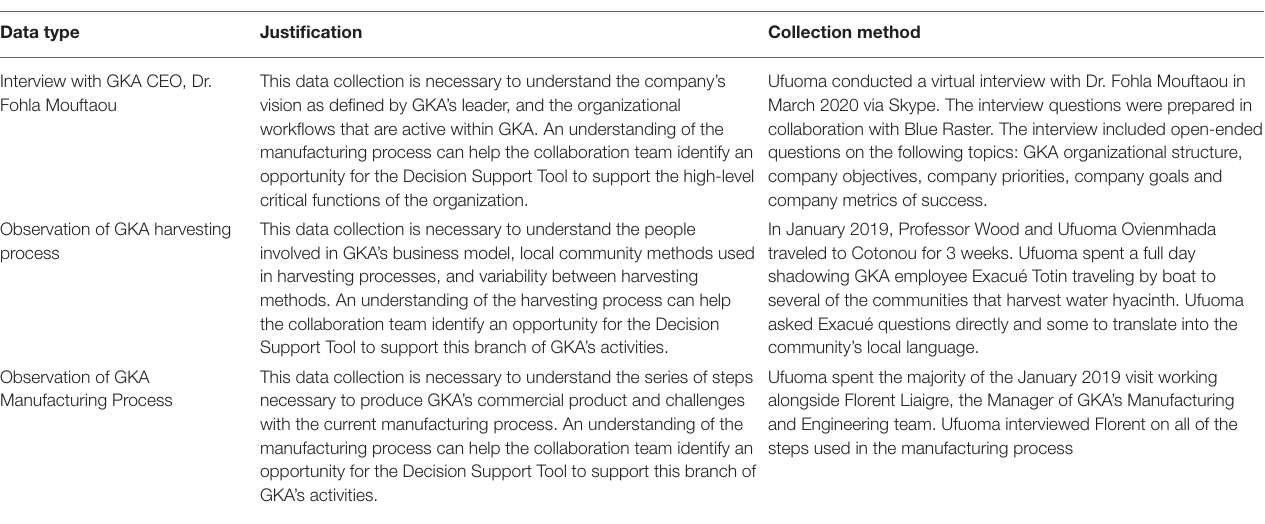
TABLE 2 | Summary of qualitative data collected to inform steps 3–5 of the